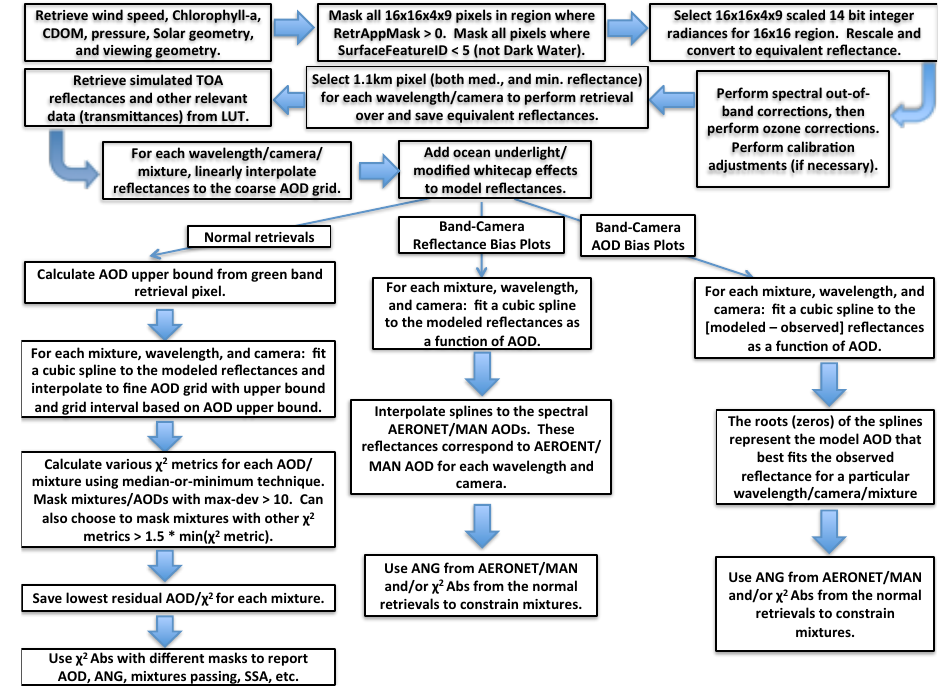
Figure 1. Flow chart summarizing the steps involved in research algorithm aerosol retrievals over dark water.